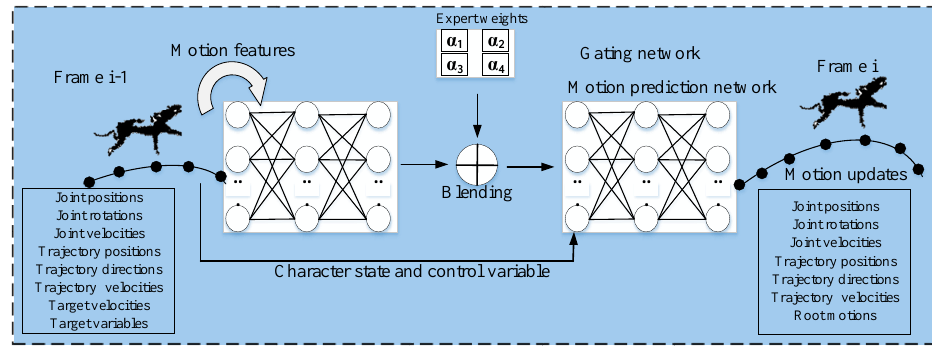
Figure 6. An architecture of MANN for motion style